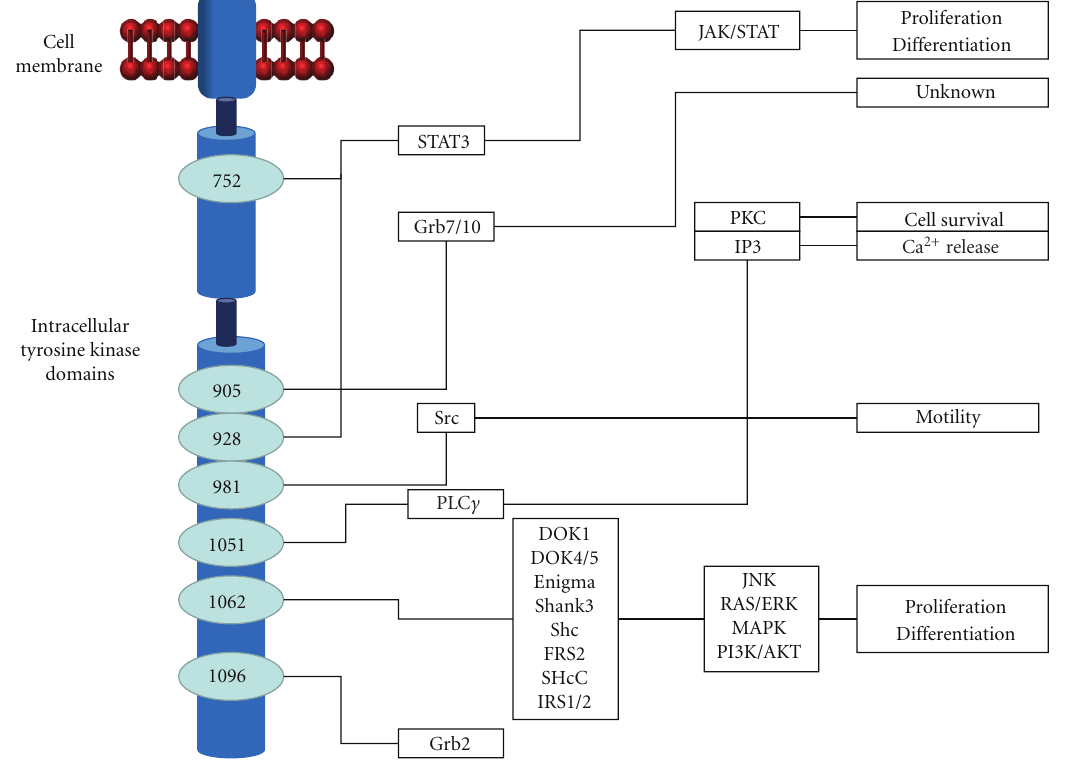
Figure 3: A summary of the signaling pathway mediated by